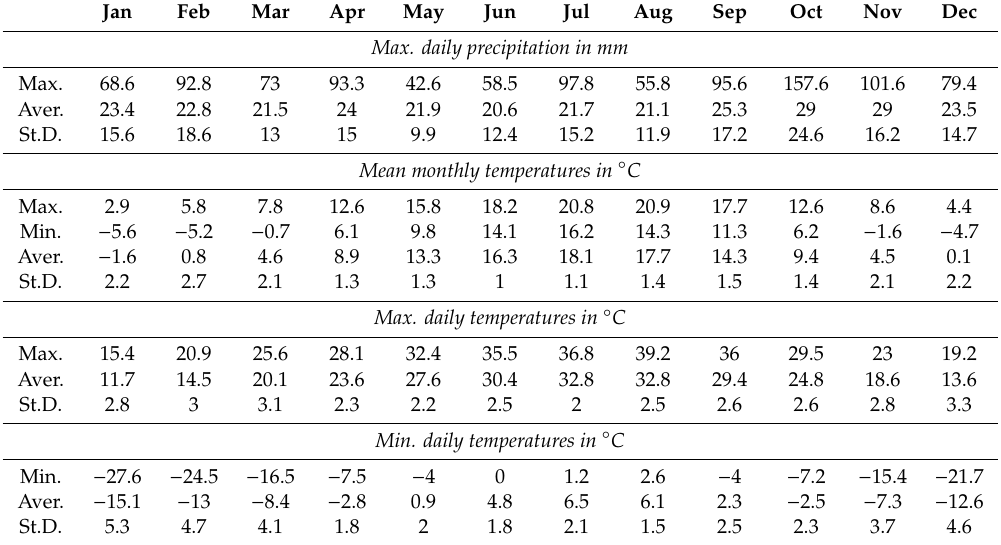
Table 1. Precipitation and temperature for the period 1948–2020 recorded at Bijelo Polje. Jan Feb Mar Apr May Jun Jul Aug Sep Oct Nov Dec Max. daily precipitation in mm Max. 68.6 Aver. St.D.